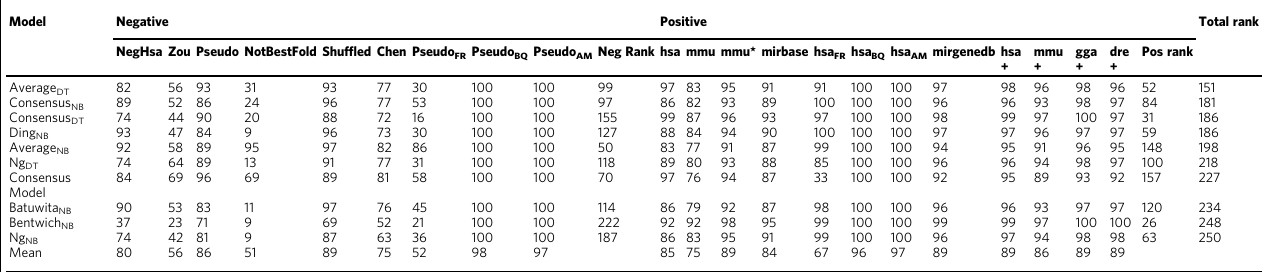
Table 3 Model performance summary Negative